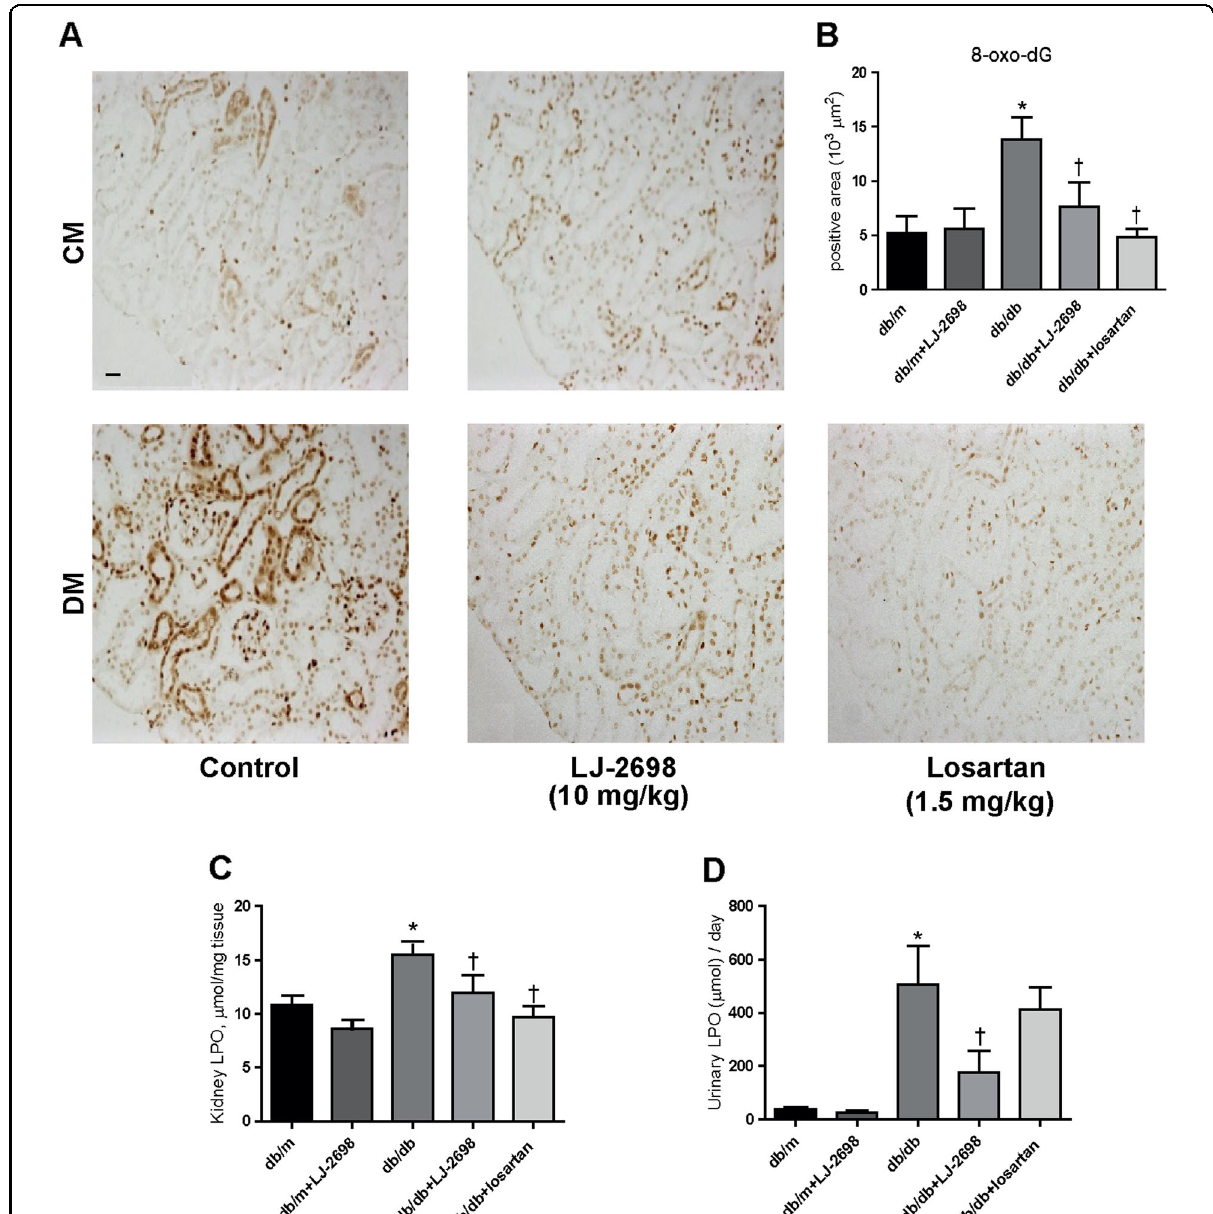
Fig. 7 LJ-2698 prevented kidney oxidative stress in db/db mice. Paraf fi n-embedded kidney sections were stained with ( a ) 8-oxo-dG antibody. The scale bar indicates 20 μ m; the original magni fi cation was 200 × . Quantitative analysis of ( b ) 8-oxo-dG in kidney cortex is depicted. The LPO concentration was detected in both ( c ) kidney tissues and ( d ) urine samples following 12 weeks of drug treatment. CM, control mice; DM, db/db diabetic mice, Data are presented as the mean ± SE of 7 – 10 mice/group. * p < 0.05 vs db/m and † p < 0.05 vs db/db